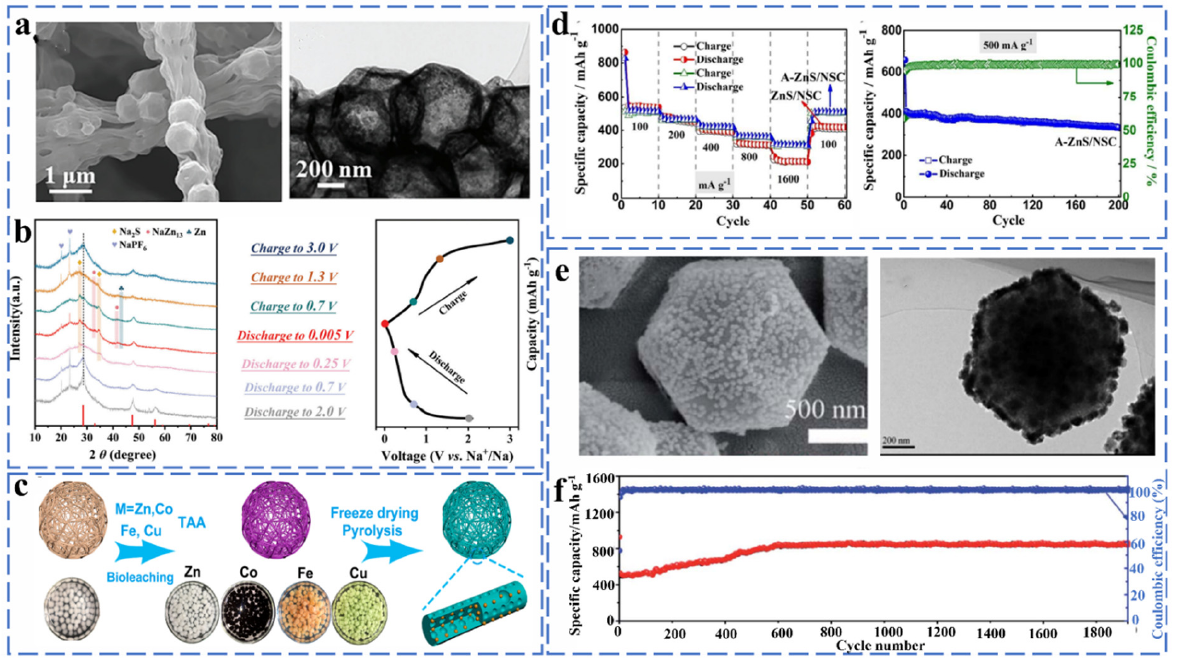
Figure 7. ( a ) SEM images at different resolutions and a TEM image of the 1.5-ZnS@CNFs-800 composite. ( b ) Ex situ XRD patterns at different cut-off voltages. Reprinted with permission from Ref. [56]. Copyright 2019, copyright. Wang, J. ( c ) Schematic illustration of the formation of the MS/NCF (MS = ZnS, Co 9 S 8 , FeS, Cu 1.81 S). Reprinted with permission from Ref. [57]. Copyright 2021 copyright. Yuan, Z. ( d ) Rate performances of ZnS/NSC and A-ZnS/NSC samples at different current densities of 100, 200, 400, 800 and 1600 mA g − 1 , respectively, and cycling performance and Coulombic efficiency of A-ZnS/NSC at 500 mA g − 1 . Reprinted with permission from Ref. [58]. Copyright 2021 copyright. Li, Z. ( e ) SEM and TEM image of ZnS/NPC. ( f ) Cycling performance of ZnS/NPC and ZnS at 0.1 A g − 1 . Reprinted with permission from Ref. [59]. Copyright 2019 copyright. Wang,